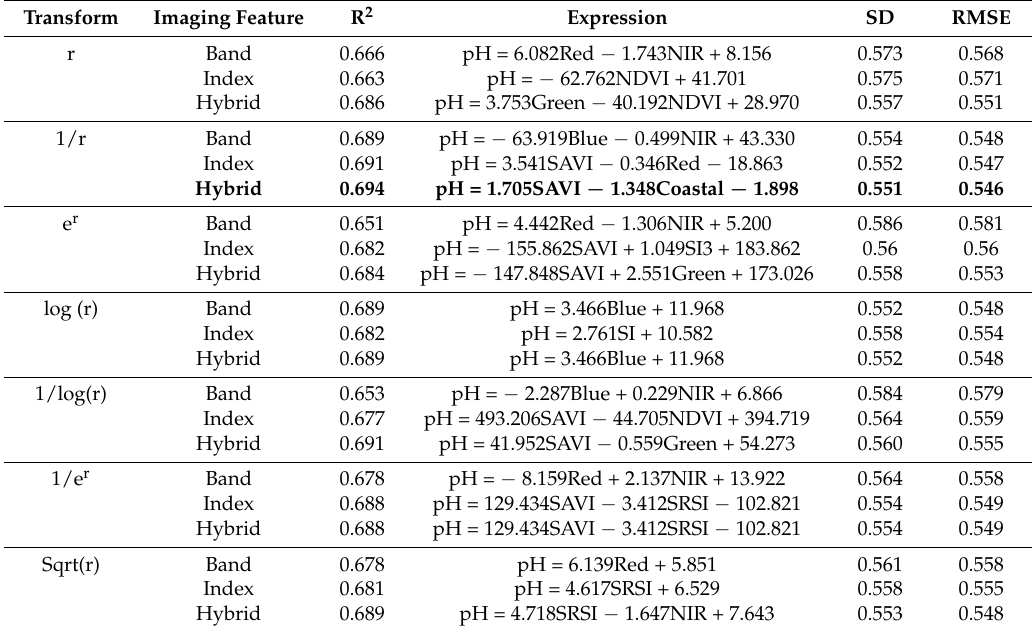
Note: r represents the normalized variables (bands and spectral indices). Table 5. The regression models for soil pH in relation to bands, spectral indices, and hybrid parameters. Transform Imaging